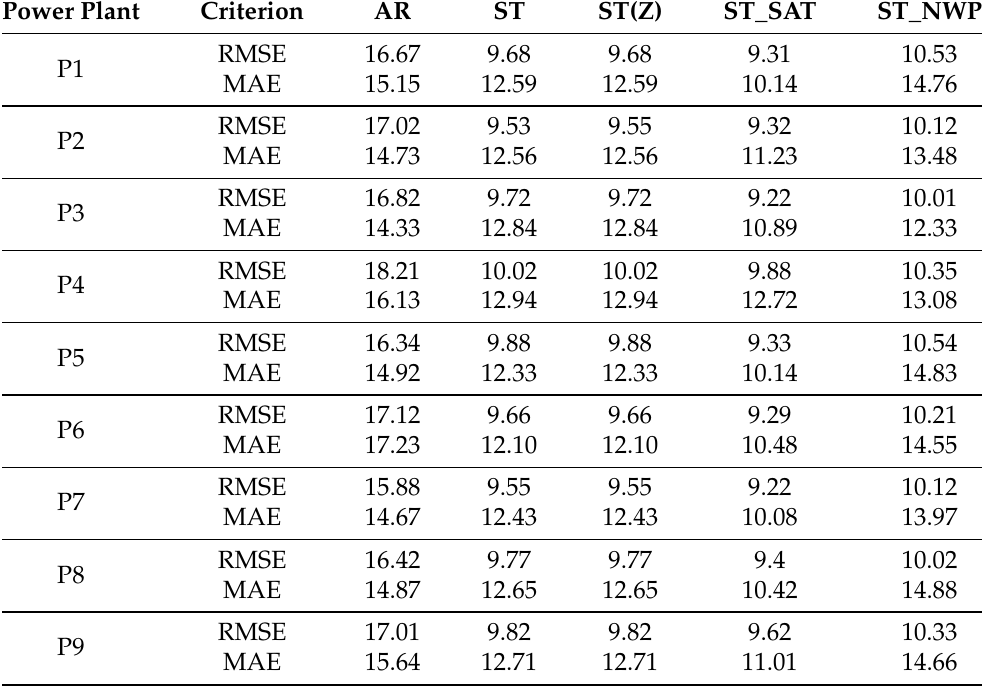
Table A1. Evaluation results for 9 power plants for the horizon of 6 h ahead (in % of Nominal